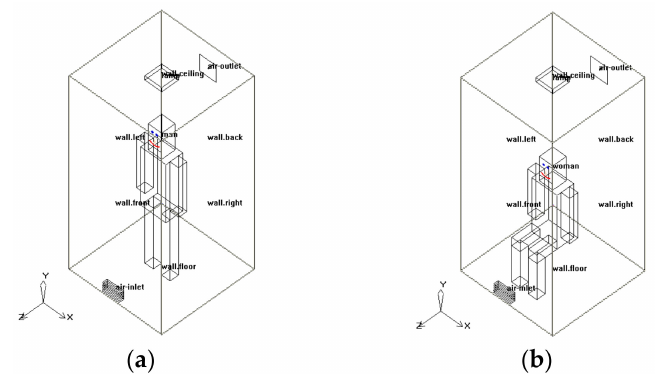
Figure 5. The three-dimensional numerical model: ( a ) standing position; ( b ) sitting